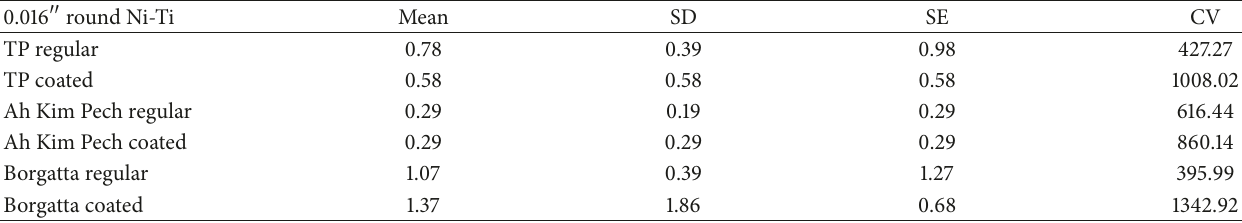
Table 2: Comparisons of the mean force (N) of the permanent deflection between the coated and regular Nil-Ti wires by manufacturer.